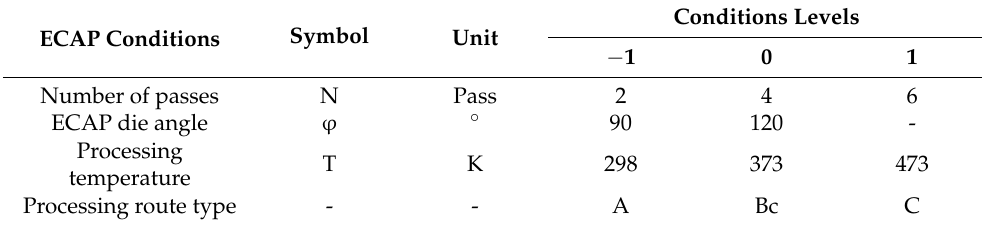
Table 1. ECAP parameters and corresponding